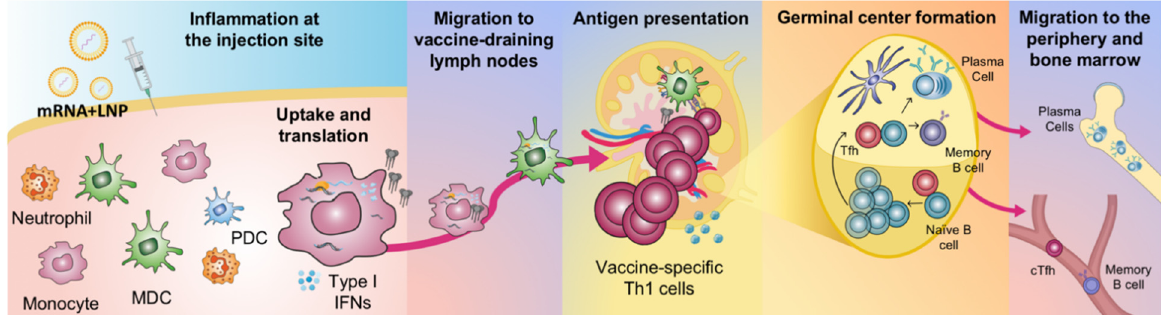
Figure 2. Proposed sequence of events leading to the generation of adaptive immune responses upon mRNA vaccination. Local inflammation at the injection site promotes the infiltration of immune cells, including neutrophils, monocytes, myeloid dendritic cells (MDCs) and plasmacytoid dendritic cells (PDCs). Neutrophils can efficiently take up LNPs, but monocytes and MDCs translate mRNA more efficiently. Secretion of type I interferons (IFNs) is stimulated. mRNA/LNP and protein antigen will disseminate and cells will migrate to the vaccine-draining lymph nodes. Antigen presentation to T cells and interactions of antigen and B cells take place at these sites. This leads to the formation of germinal centers, which results in the generation of memory B cells and antibody-producing plasma cells that reside to the bone marrow. The basic illustration was made by Elizabeth Thompson and some elements were created using BioRender.com.